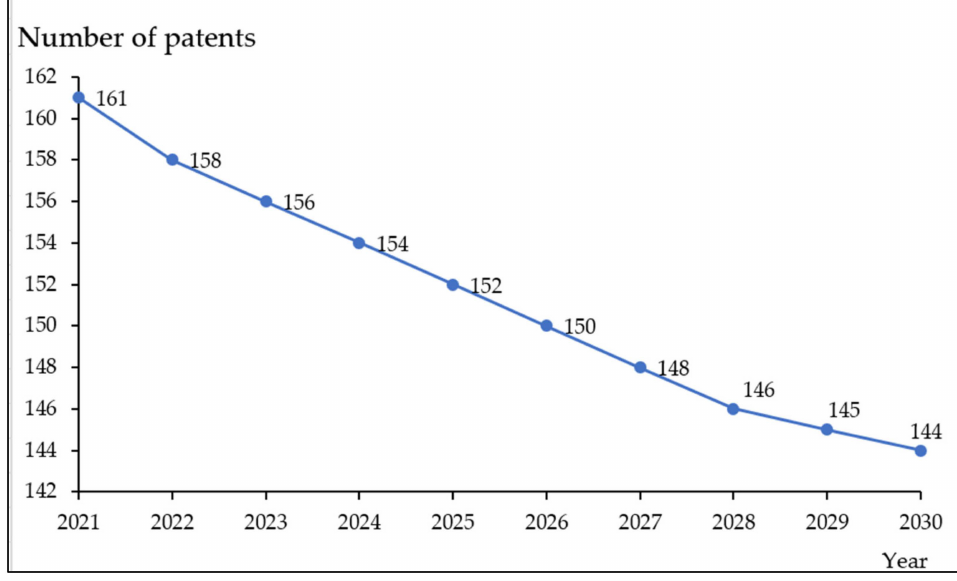
Figure 9. Prediction of number of patents by ensemble learning bagging